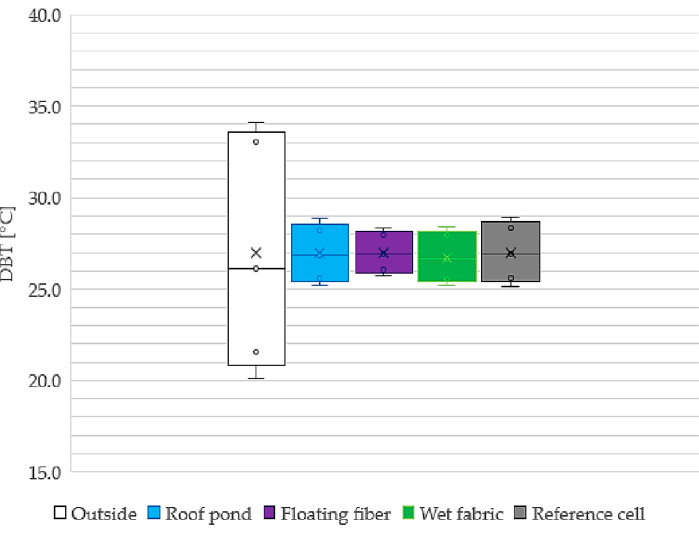
Figure 14. Box plot of the indoor air temperatures in the hot humid season.